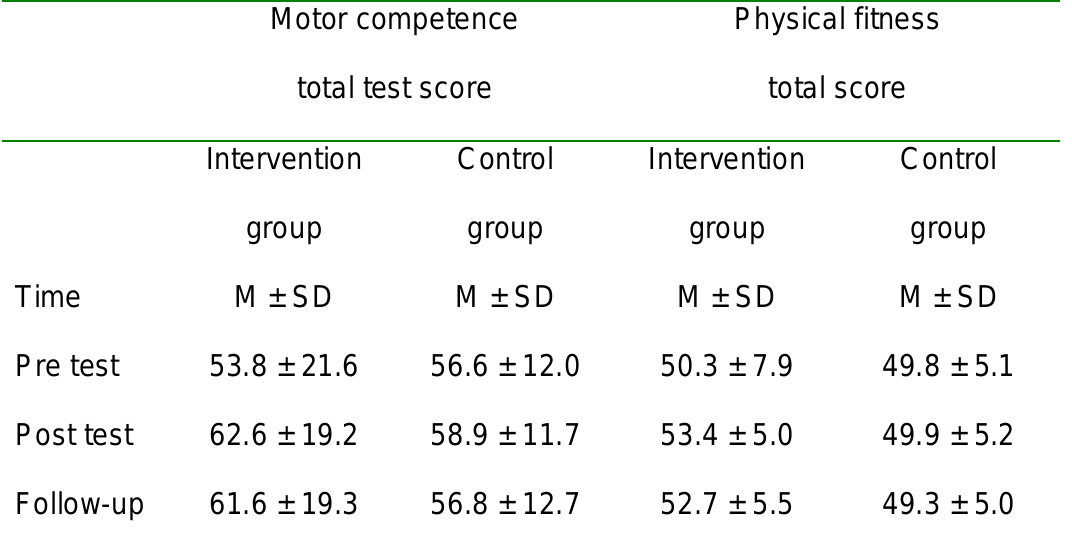
Means and SDs for motor competence and physical fitness scores of each group across the three time